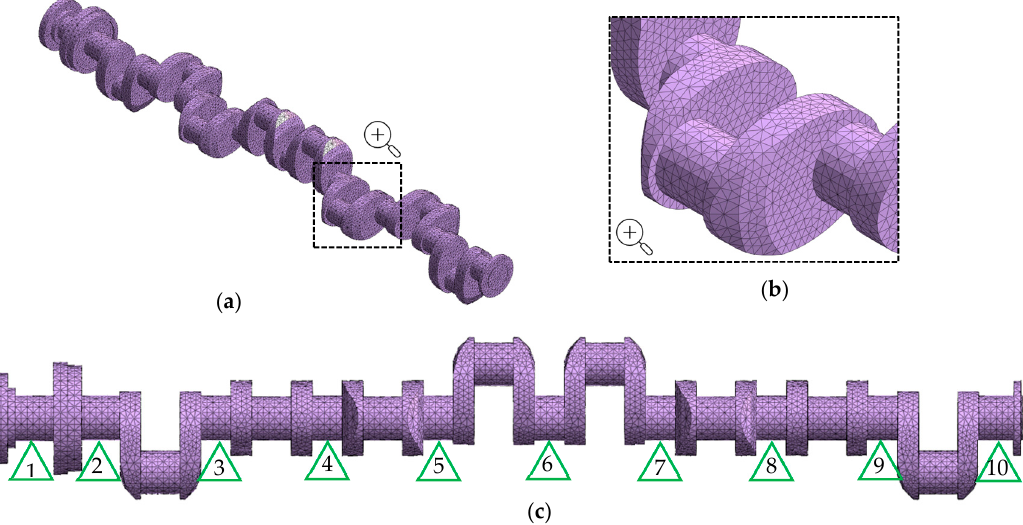
Figure 4. Finite element model of the analyzed shaft ( a ) isometric view; ( b ) mesh close-up; ( c ) main journals support.